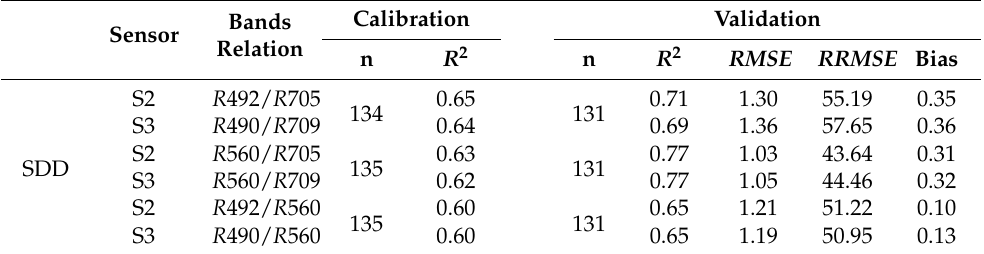
Table 5. Calibration and validation results for Secchi disk depth (SDD). Only results with a calibration with R 2 > 0.4 are shown. All are linear regressions. RMSE (m); RRMSE (%); bias (m). R 2 : coefficient of determination; RMSE : root–mean–squared error; RRMSE : relative root–mean–squared error.